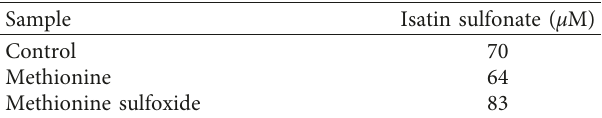
Scheme 1: Previously proposed pathway for methionine-catalysed ozone formation via methionine oxidation products such as methionine persulfoxide 2 , methionine sulfoxide 3 , and a trioxyanionic derivative 4 [17] and suggested possibility of ozone and methionine sulfoxide formation from persulfoxide 2 via tetroxide anion 5 Table 1: Yield of isatin sulfonate during the myeloperoxidase- catalysed generation of singlet oxygen in the presence of methi- onine or methionine sulfoxide.